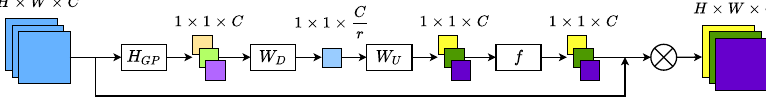
Figure 5. The architecture of the channel attention.